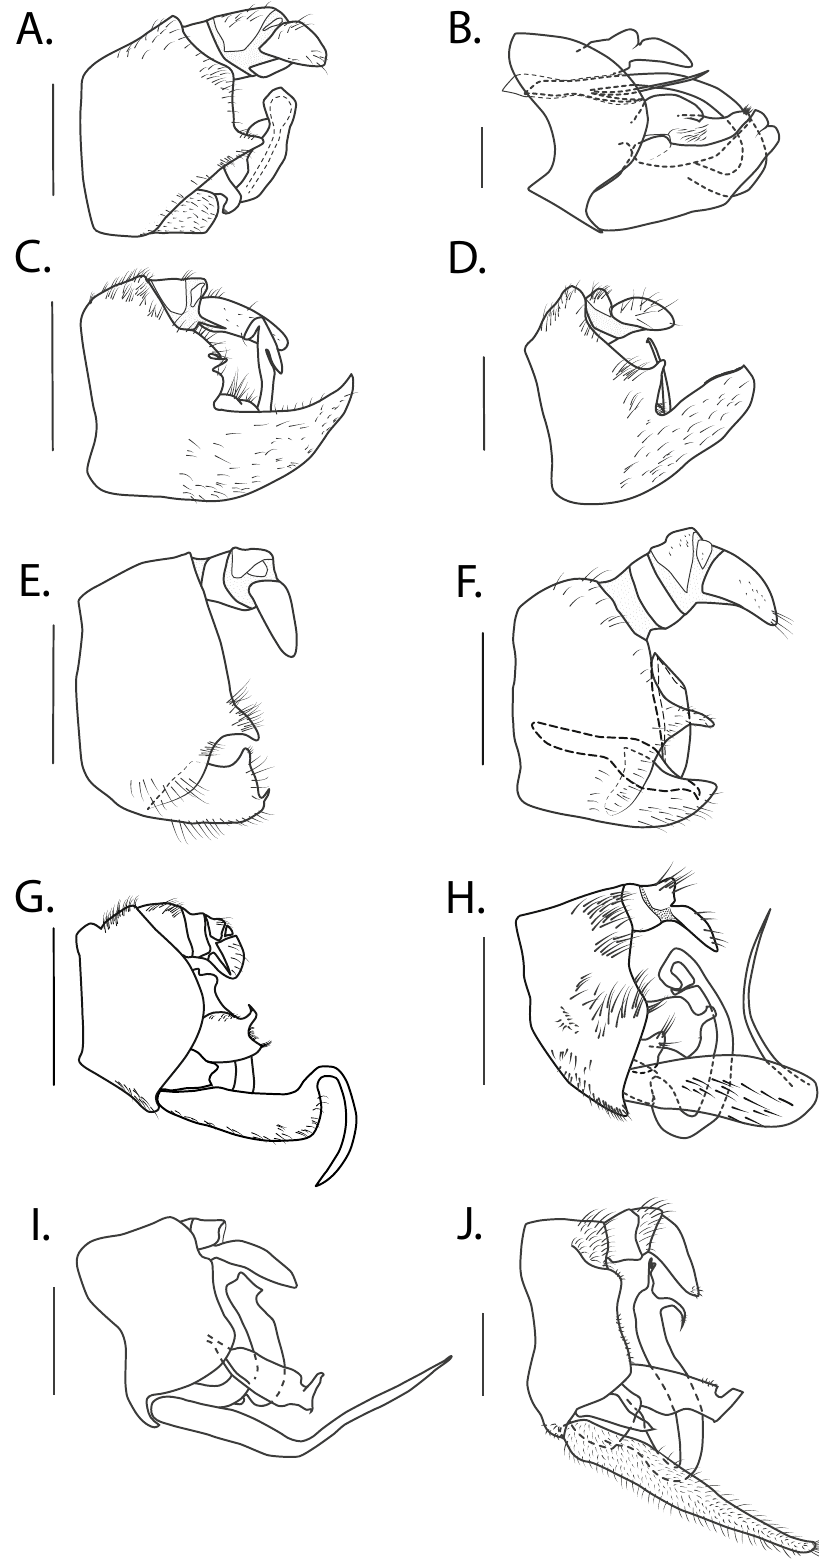
Figure 2. Different morphological configurations observed for the male terminalia. ( A ) Considia nitidula (Breddin, 1902), ( B ) Cercopis sanguinolenta (Scopoli, 1763), ( C ) Pachacanthocnemis bella (Walker, 1851), ( D ) Prosapia simulans (Walker, 1858), ( E ) Cosmoscarta herossa Jacobi 1921, ( F ) Radioscarta sp. ( G ) Eoscarta borealis (Distant, 1878) ( H ) Callitettix versicolor (Fabricius, 1794), ( I ) Aufidus albonigrus Le Cesne & Souliers 2021 J. Wawi mehi Soulier-Perkins & Cesne